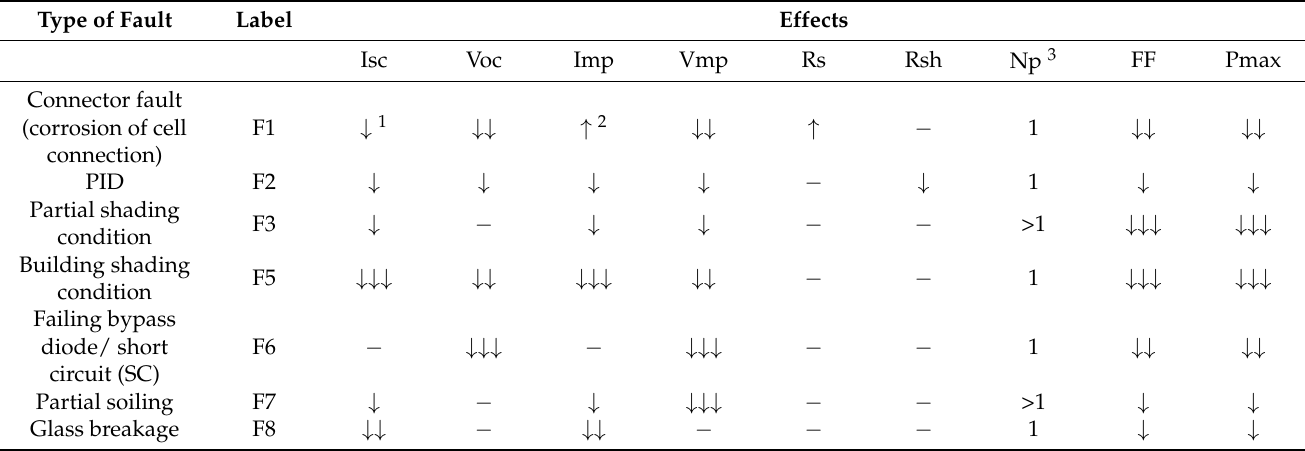
Table 4. Impacts of different faults on different PV